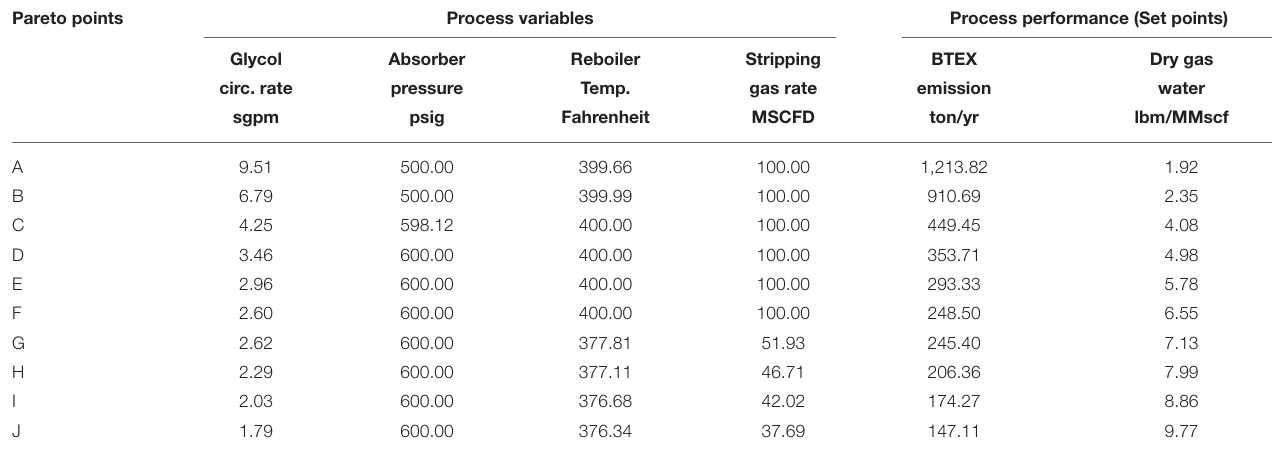
TABLE 1 | Optimized process condition for the nine Pareto points.